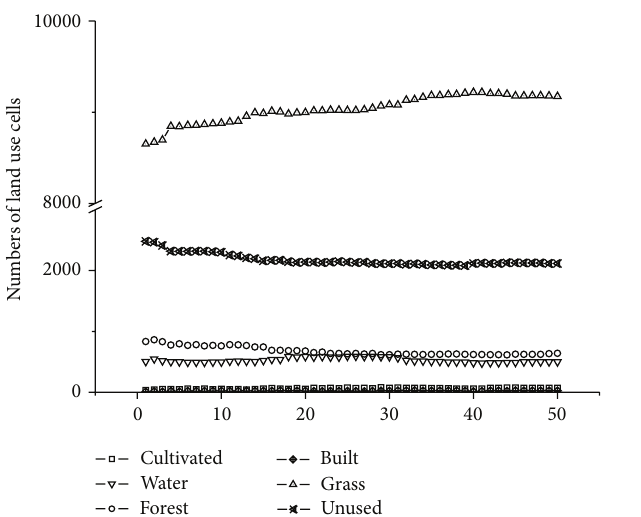
Figure 2: The underlying land surface structure in the next 50 years. The grid cell size is 2km × 2km.